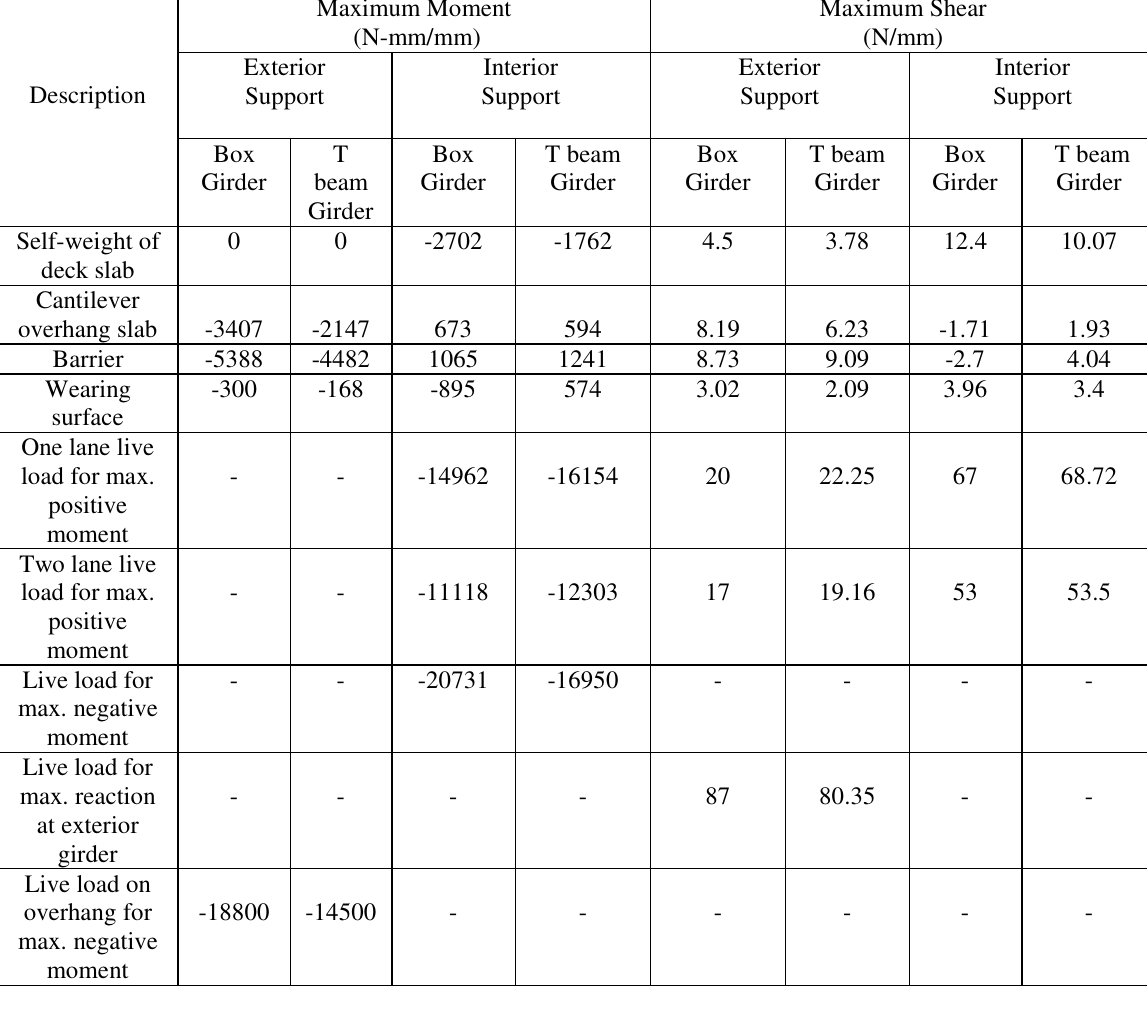
TABLE 3. FORCE EFFECTS FOR SLAB DESIGN FOR BOX AND T BEAM GIRDER (UNIT STRIP)